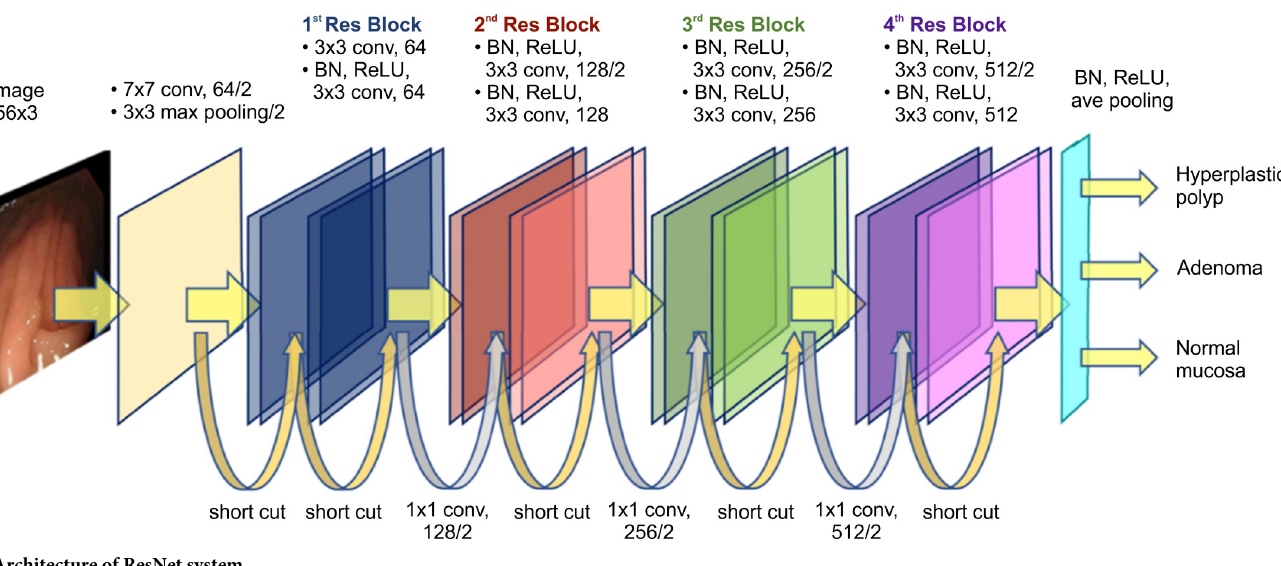
Fig 3. Architecture of ResNet